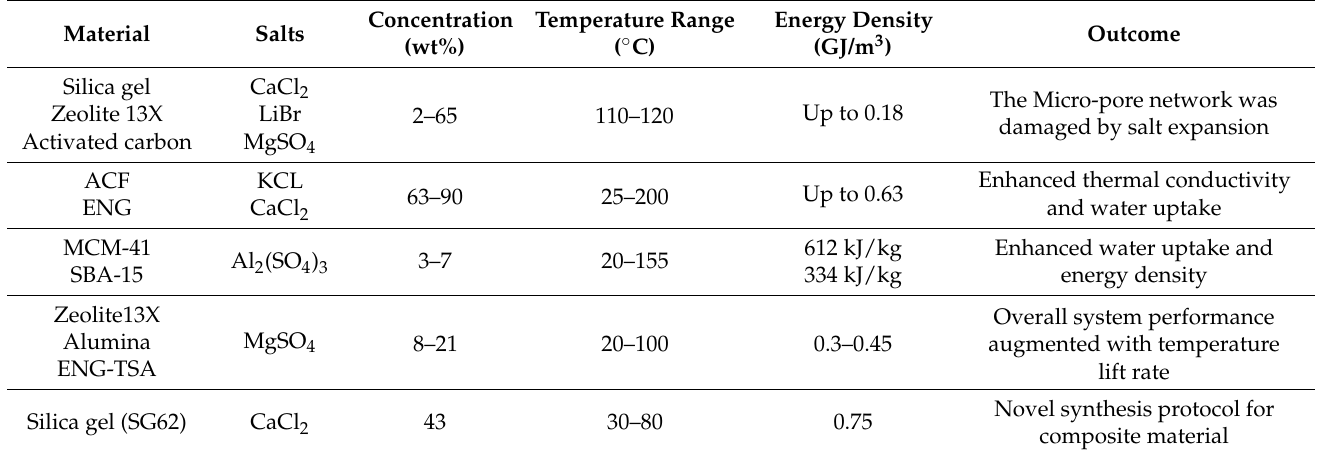
Figure 10. Working principle of composite materials depicting numerous steps involved in charging/discharging [98]. Table 8. Summary of composite